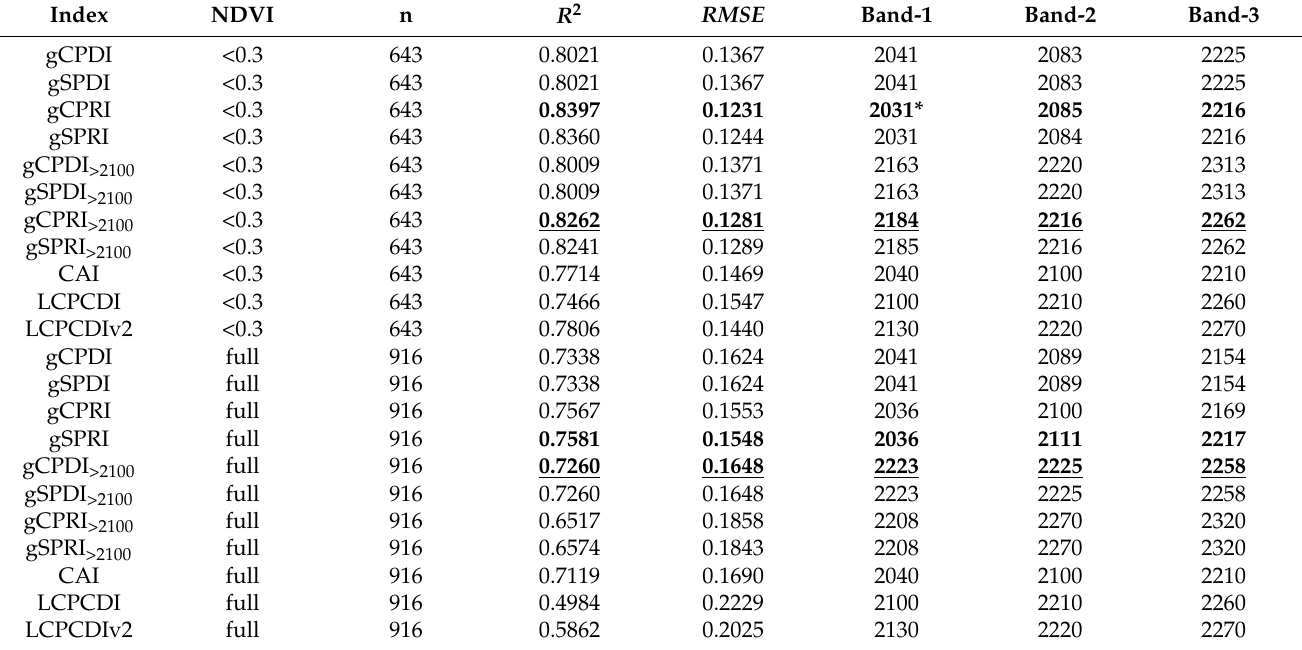
Table 4. Three-band wavelength shift analysis for 1 nm interval BARC dataset. The rows with bold text indicate the top-performing indices in f R estimation with and without the band 1 > 2100 nm con- straint and the NDVI < 0.3 and full-NDVI datasets. The underlined values indicate top performance with the band 1 < 2100 nm constraint. Band-1, Band-2, and Band-3 denote the wavelengths with the highest f R estimation performance for both R 2 and RMSE , with the only exception to this being gCRPI where R 2 top-performing Band-1 wavelength was 2031 nm, while RMSE top-performing Band-1 wavelength was 2032 nm (2031* denotes this